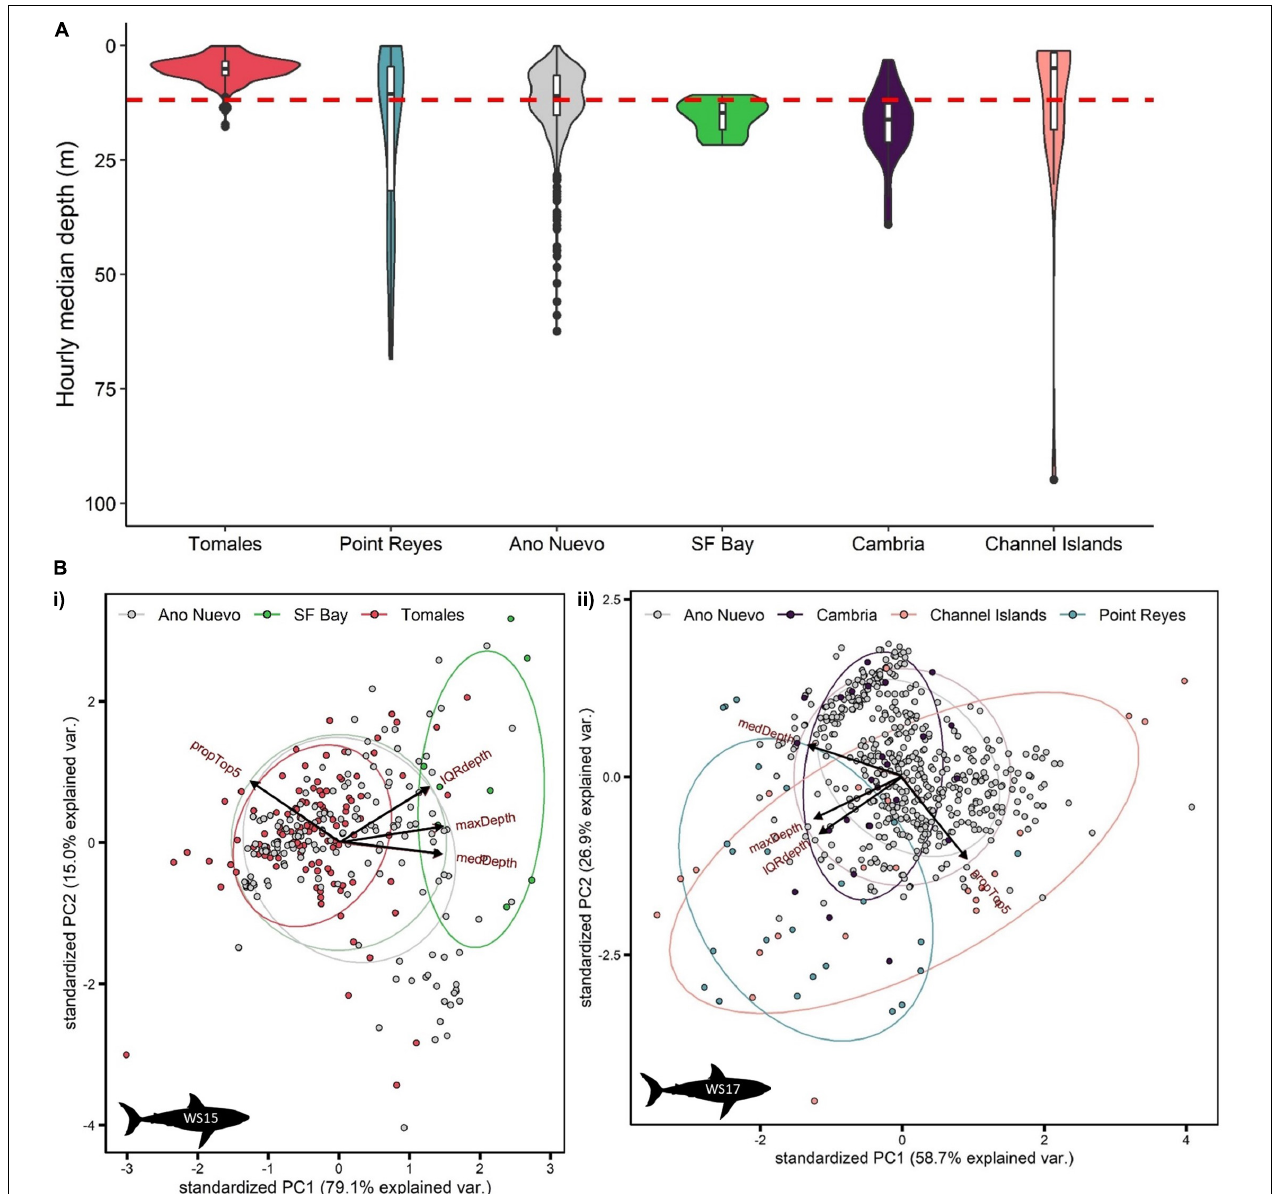
FIGURE 5 | Summarized depth data from PSATS recovered from double-tagged white sharks Carcharodon carcharias in the coastal phase of their migration in the NE Pacific. Site-specific vertical behaviors were determined by date-time matching time-series data with acoustic detection data. Individual sharks were matched to a site either by recording > 1 detection per day at a site, or by a photo-identification match. (A) Violin plot of hourly median depth by site ( n = 84 days). The red dashed line indicates the average median depth of all site-specific data (11.8 ± 11.3 m). (B) Principal component analysis of hourly summarized depth data for two sharks (i) WS15 ( n = 298 h) and (ii) WS17 ( n = 556 h). Input variables were % use top 5 m, maximum depth, median depth and interquartile range in depth. Points are colored by